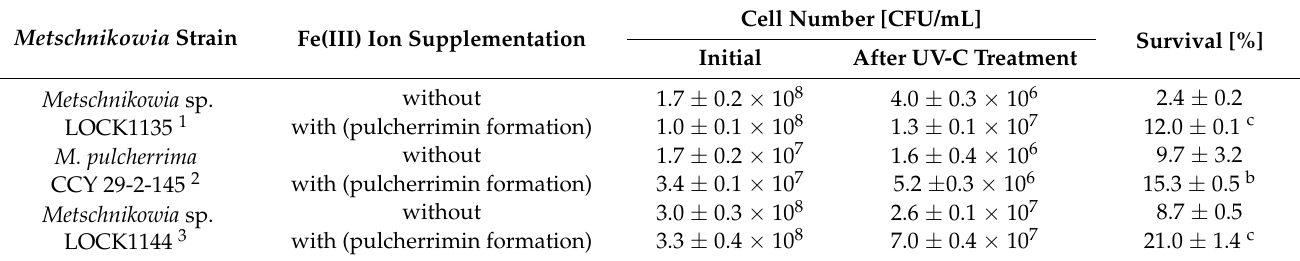
Table 1. Survival of yeast cells after exposure to UV-C radiation.